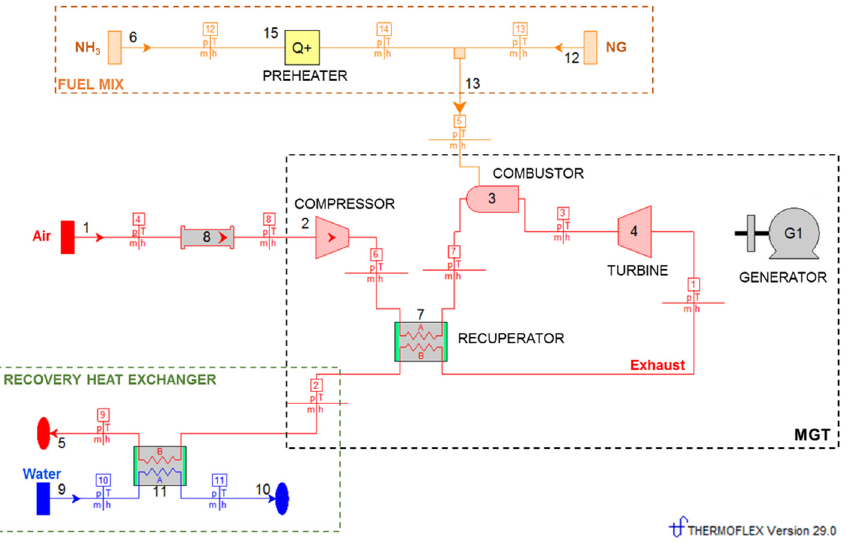
Figure 1. Layout of the micro gas turbine system. Table 1. Normalized pressure loss at the design point.